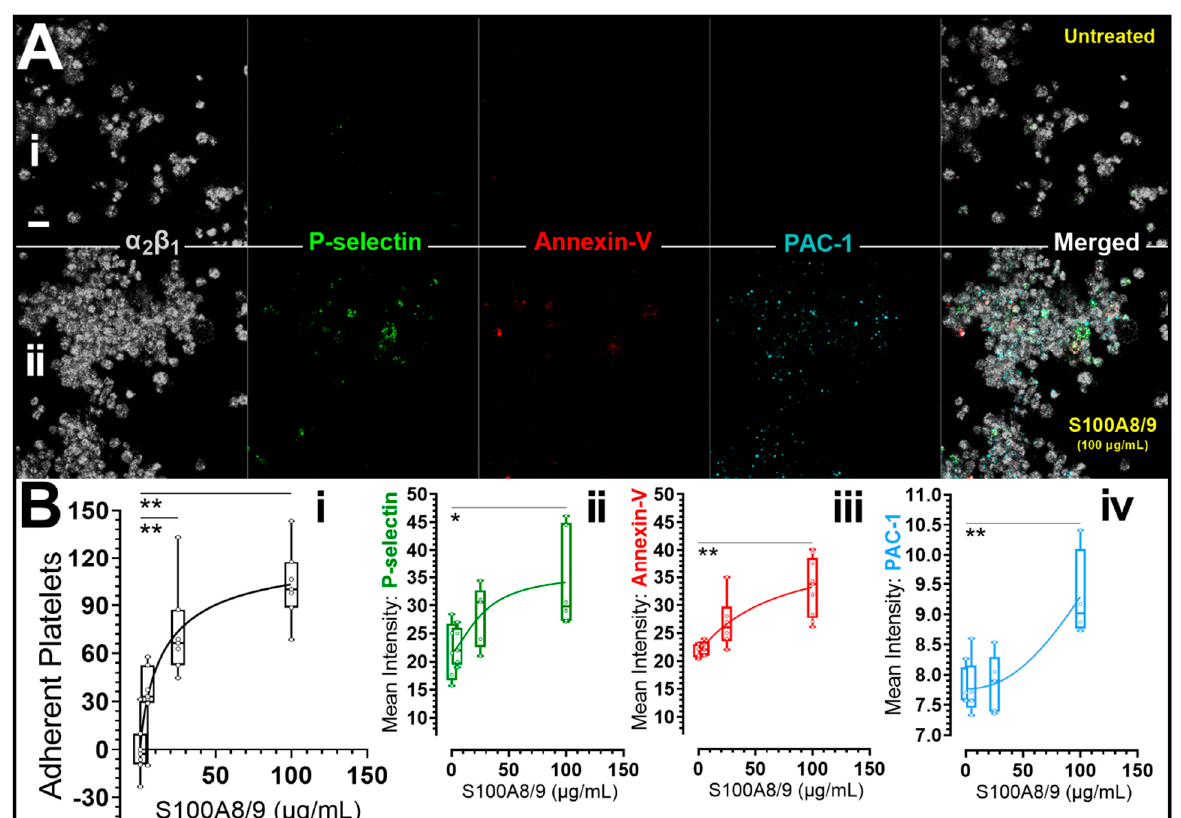
Figure 4. Recombinant human S100A8/S100A9 heterodimer induced platelet P-selectin membrane expression, integrin activation and clumping in vitro. Citrated platelet-rich plasma (PRP) from non- pregnant participants was untreated or preincubated with recombinant human S100A8/S100A9 (Catalog # 8226S8, Bio-Techne Canada, Toronto, ON, Canada) and labelled with human integrin α 2 /CD49b AlexaFluor ® 405-conjugated Antibody (Grey), AlexaFluor ® 488 anti-human CD62P (P-Se- lectin) antibody (Green), annexin V, AlexaFluor ® 568 conjugate (Red) and Alexa Fluor ® 647 anti- human CD41/CD61 (PAC-1) antibody (Cyan). PRP was then recalcified to 1 mM calcium and al- lowed to adhere (45 min) to surfaces precoated with bovine serum albumin (BSA). Image panel A shows representative extended focus view of untreated ( Ai ) and 100 ug/mL S100A8/S100A9 treated ( Aii ) platelets adherent to BSA surfaces. In panel ( Bi – iv ), the mean fluorescent signal intensities in pooled experiments are shown. Data were tested for normality using the Shapiro-Wilk test ( p < 0.05). Data were then analyzed using GraphPad Prism 9.3 (San Diego, CA) and presented as box-and- whiskers plots showing minimum to maximum values. The dots/points in the chart represent raw data (replicate experiments inclusive). The medians and interquartile ranges of data are represented by the horizontal line through the box and height of the box, respectively. Statistical significance was determined by 1-way ANOVA and Bonferroni post hoc tests. p < 0.05 (*) or p < 0.01 (**) were considered significant. Images were captured at Nyquist using a Nikon A1R laser scanning confocal microscope (original objective magnification, ×63) and analyzed using Volocity ® Software (Quorum Technologies, Lewes, UK). Scale bars: 5 μ m.